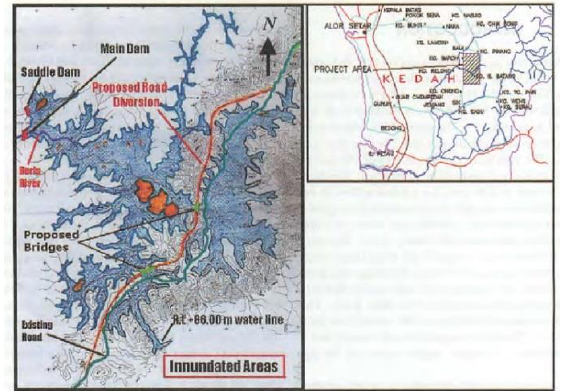
Figure 1: Location of the Beris Dam in Kedah Darul Aman. [From Figure 1 (Jamaluddin and Yusoff,